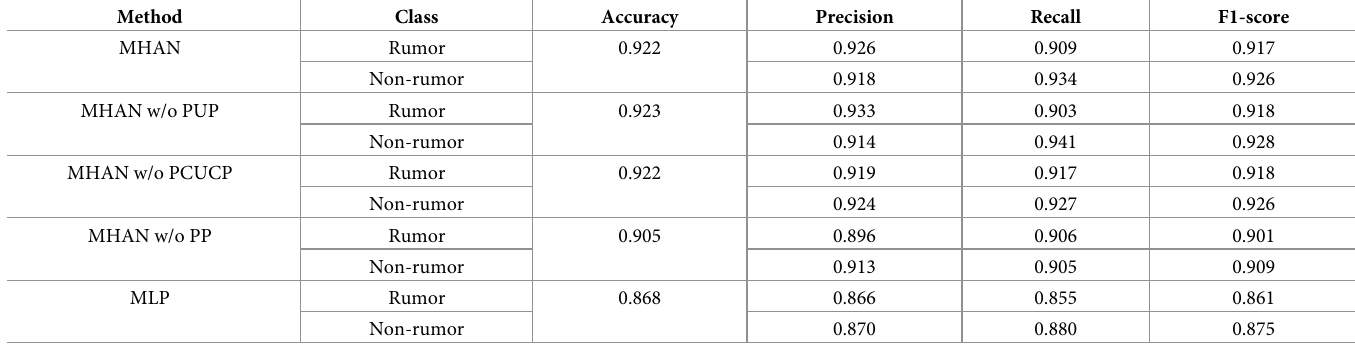
Table 4. Experimental results on the Weibo2021